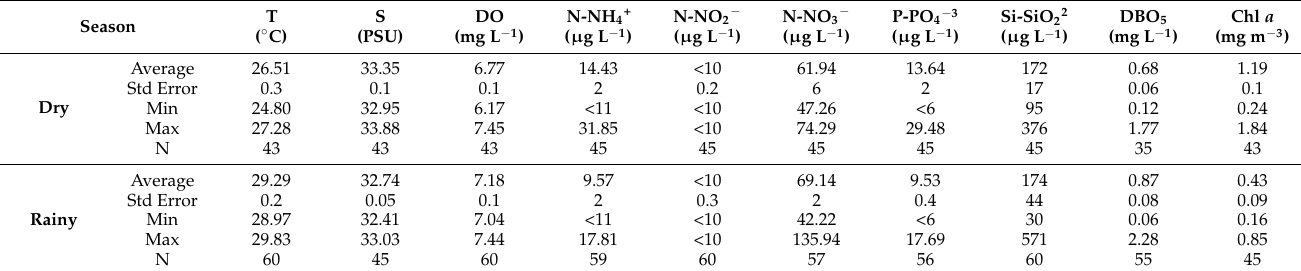
Table 1. Descriptive statistics of the evaluated parameters of the 15 stations of the Gulf of Papagayo, during the period October 2016–February 2018. (N: number of samples per parameter, average, Std. Error: standard error, Min: minimum value and Max: maximum value and reference